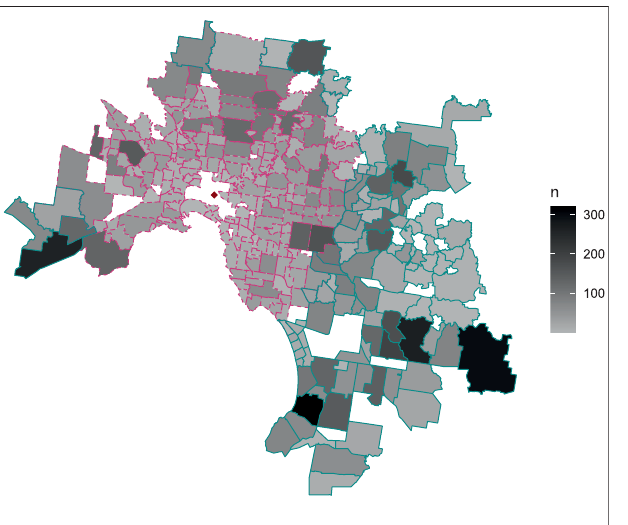
FIGURE 9 | Map of Melbourne suburbs included in this study, with greyscale shading to represent sample sizes. Pink dashed polygon borders contain suburbs classi fi ed as near to the Central Business District (i.e., ≤ 25km), and blue solid polygon borders represent those classi fi ed as far ( > 25km). The solid red diamond represents the location of the CBD.